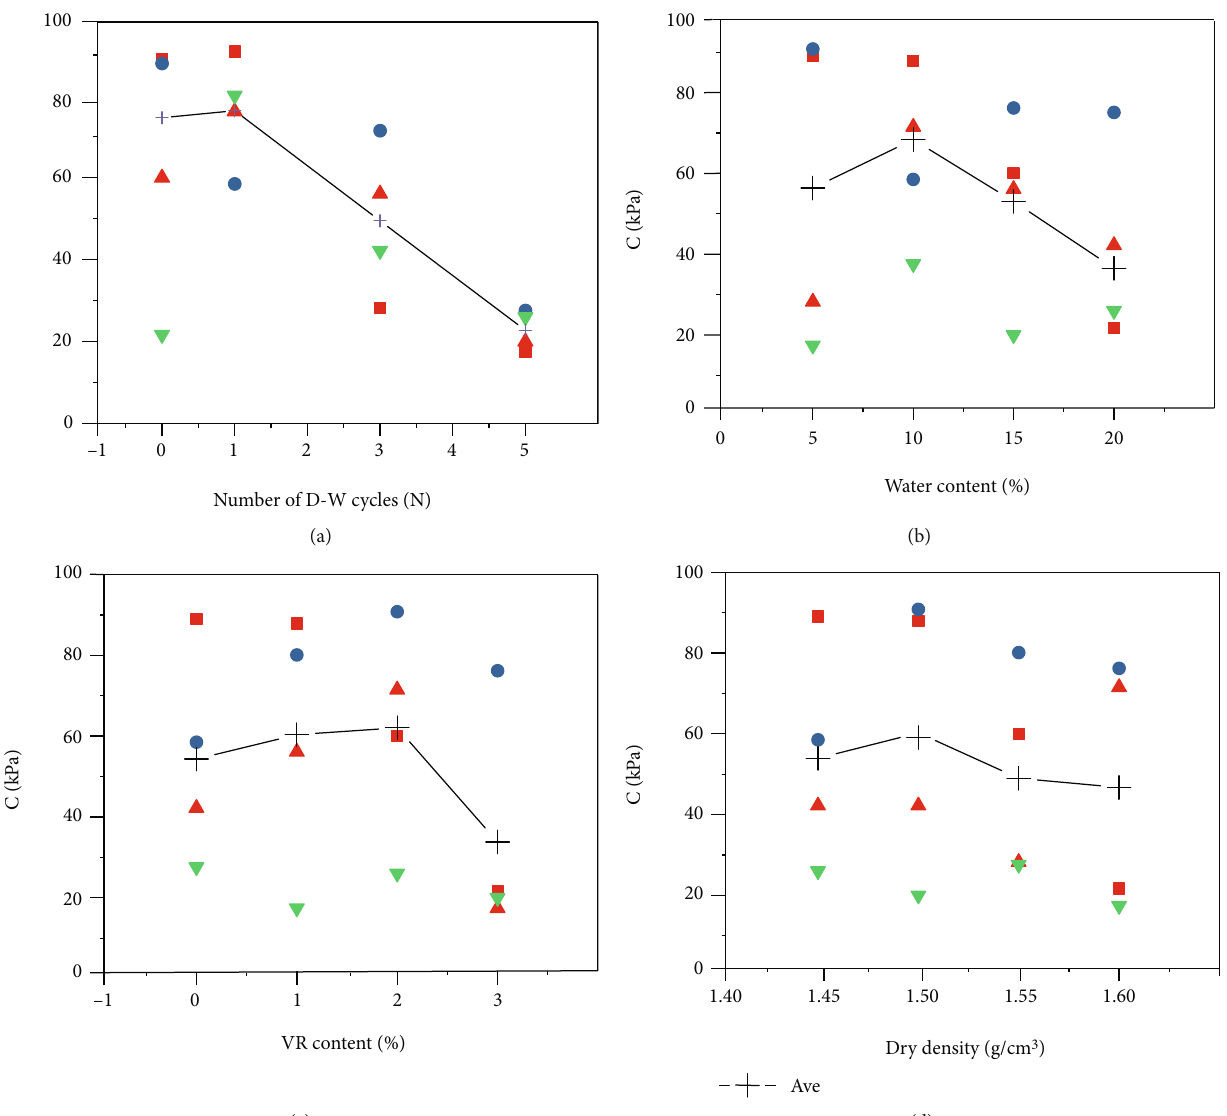
Figure 6: (a) Cohesion vs. number of W-D cycles; (b) cohesion vs. water content; (c) cohesion vs. VR content; (d) cohesion vs. dry